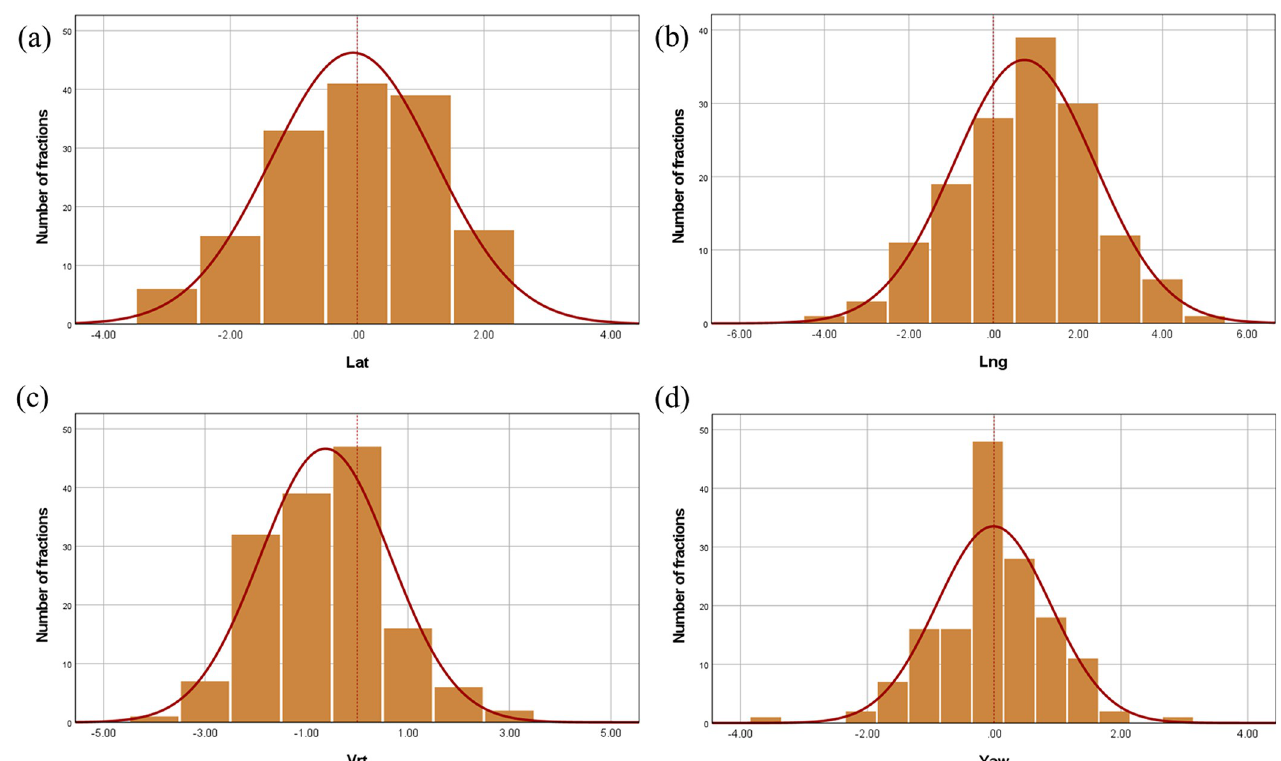
Fig 5. Histograms and normal distribution curves of the setup errors in the translation and rotation for the head-tilted supine position (ht-SP). Setup errors in the (A) lateral, (B) longitudinal, (C) vertical, and (D) yaw directions.